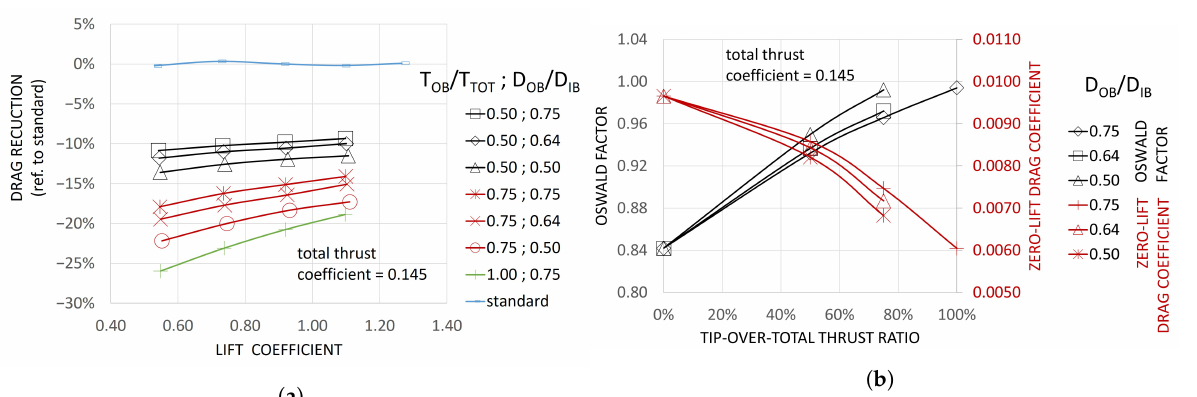
Figure 12. OB propeller effect in climb conditions ( M = 0.251; Re = 12.8 × 10 6 ): ( a ) Relative drag reduction regarding power-off case (OFF, Table 3); ( b ) Oswald factor and zero-lift drag coefficient.